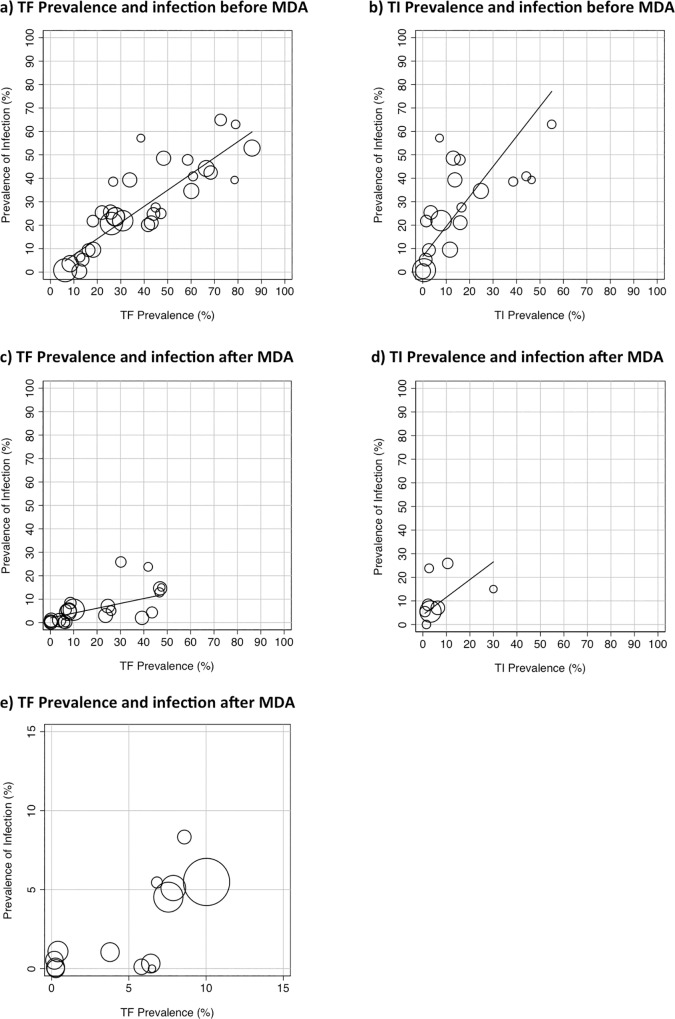
The relationship between the prevalence of disease signs and infection before and after the introduction of MDA.(a) Community prevalence of TF (or TF/TI) vs. the community prevalence of C. trachomatis infection before the introduction of MDA. (b) Community prevalence of TI vs. the community prevalence of C. trachomatis infection before the introduction of MDA. (c) Community prevalence of TF (or TF/TI) vs. the community prevalence of C. trachomatis infection after the introduction of MDA. (d) Community prevalence of TI vs. the community prevalence of C. trachomatis infection after the introduction of MDA. (e) Community prevalence of TF (or TF/TI) vs. the community prevalence of C. trachomatis infection after the introduction of MDA, showing only the communities with less than 15% TF. Data from population-based studies, summarised in Tables 1 and 2. The size of the circles reflects the sample size. Line fitted by linear regression, weighted by the size of the studies.